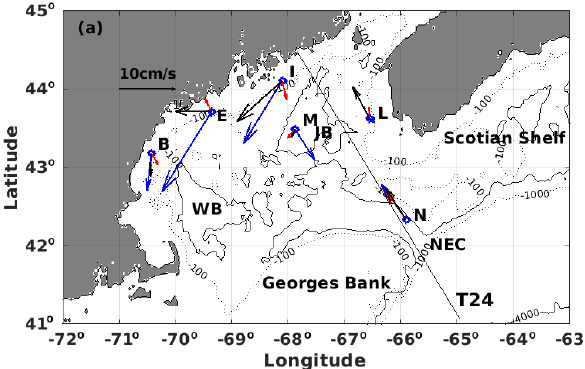
Figure 9. Map of Gulf of Maine with the mean upper ocean (50m averaged) current vectors from in situ measurements at six buoy sites (N, L, M, I, E and B) in blue, and the mean geostrophic velocity vectors inferred from MDT_CNES_CLS13 in red and MDT_CNES_CLS18 in black. One Jason altimeter track 24 (T24) is also shown. (Abbreviations – JB: Jordan Basin; WB: Wilkinson Basin; NEC: northeast